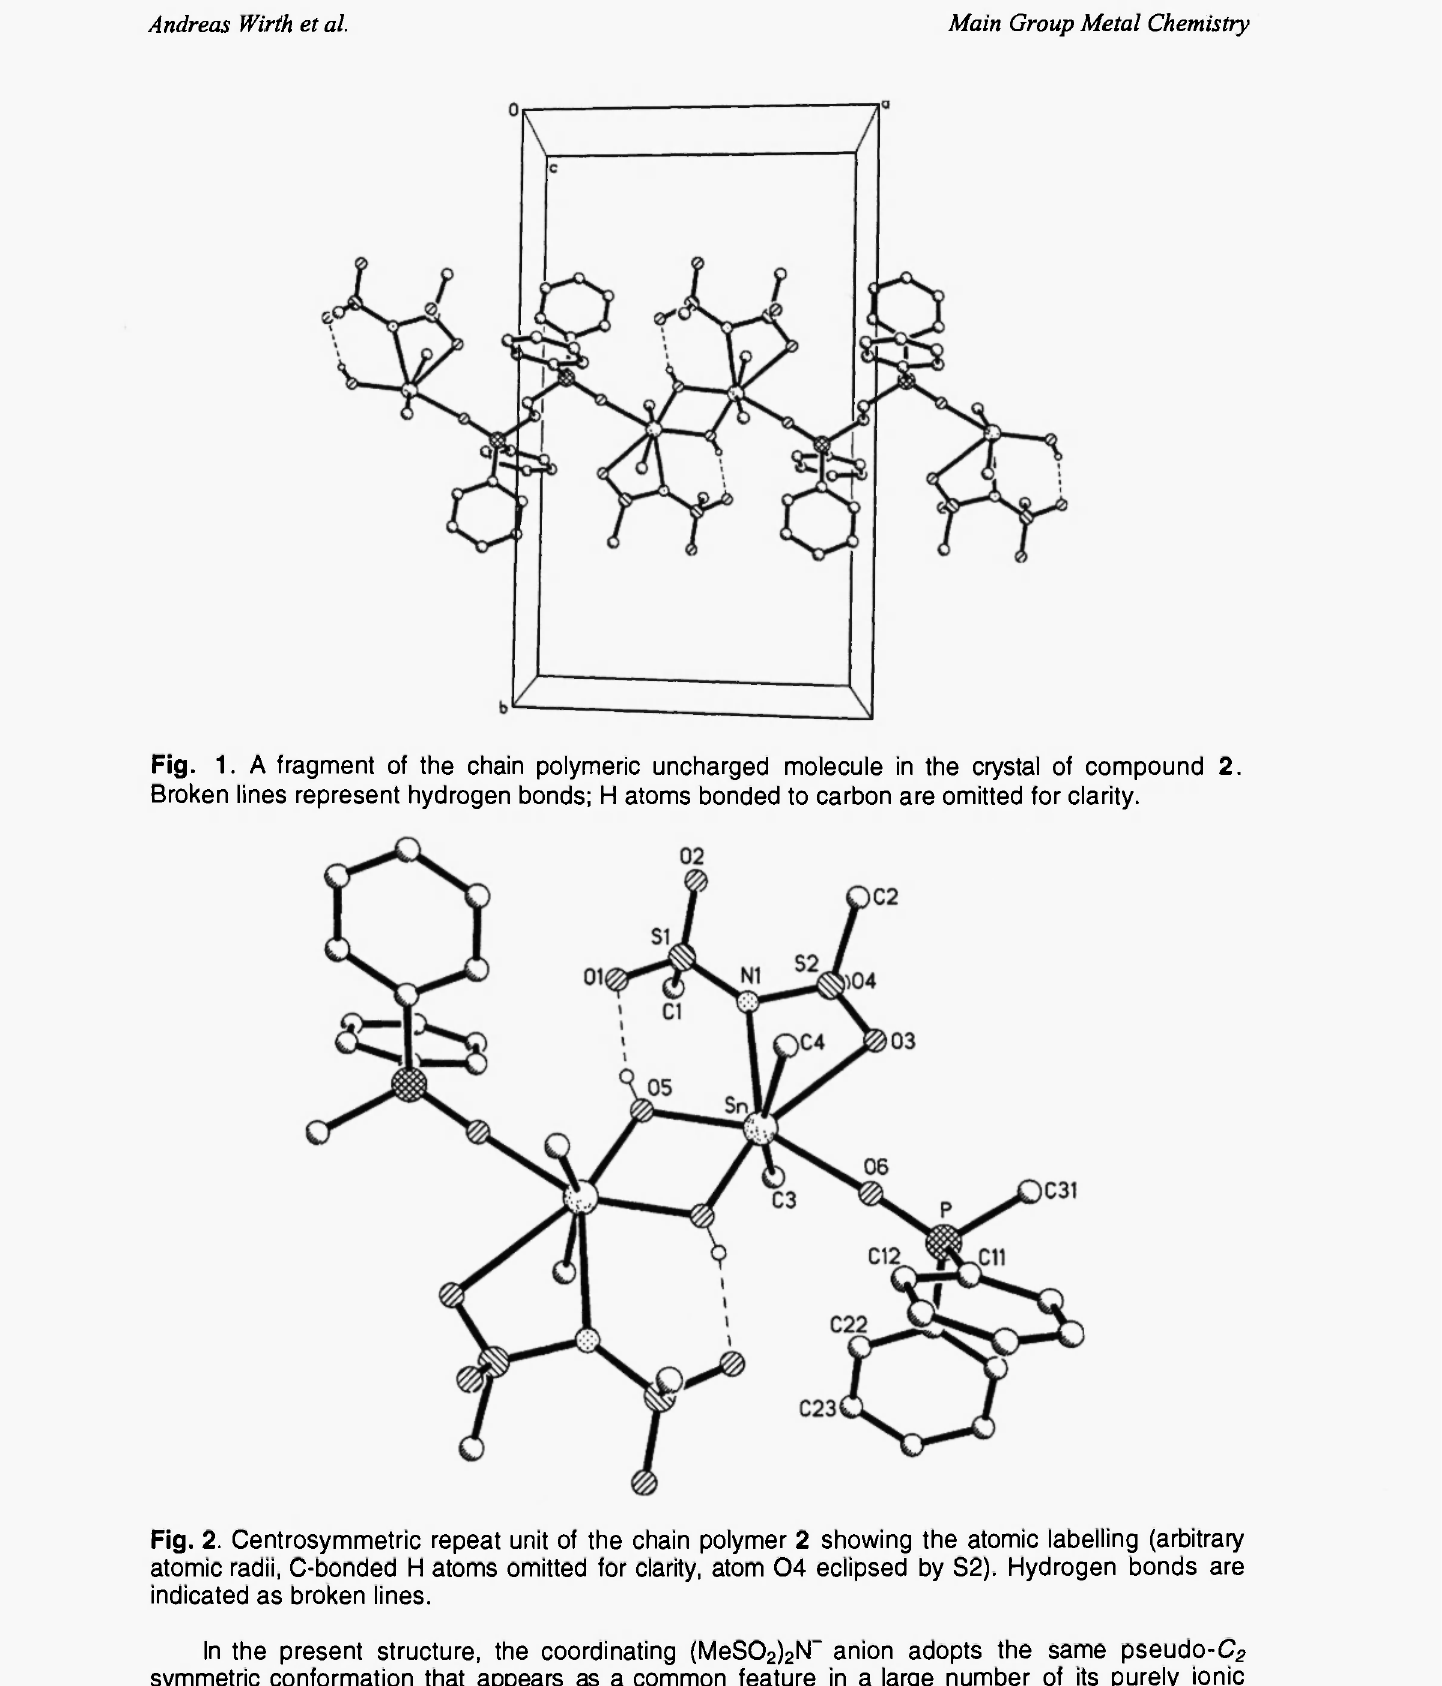
Fig. 2. Centrosymmetric repeat unit of the chain polymer 2 showing the atomic labelling (arbitrary atomic radii, C-bonded Η atoms omitted for clarity, atom 04 eclipsed by S2). Hydrogen bonds are indicated as broken